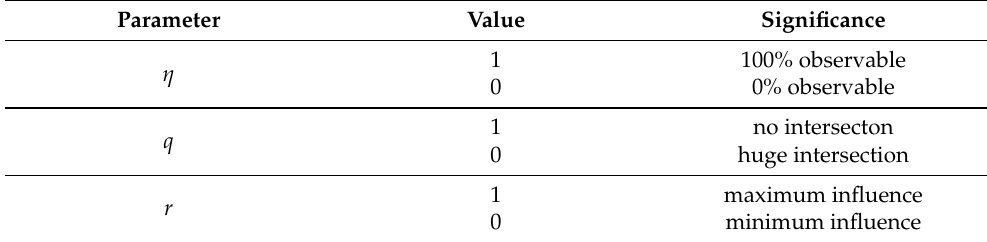
Table 3. Meanings of the used